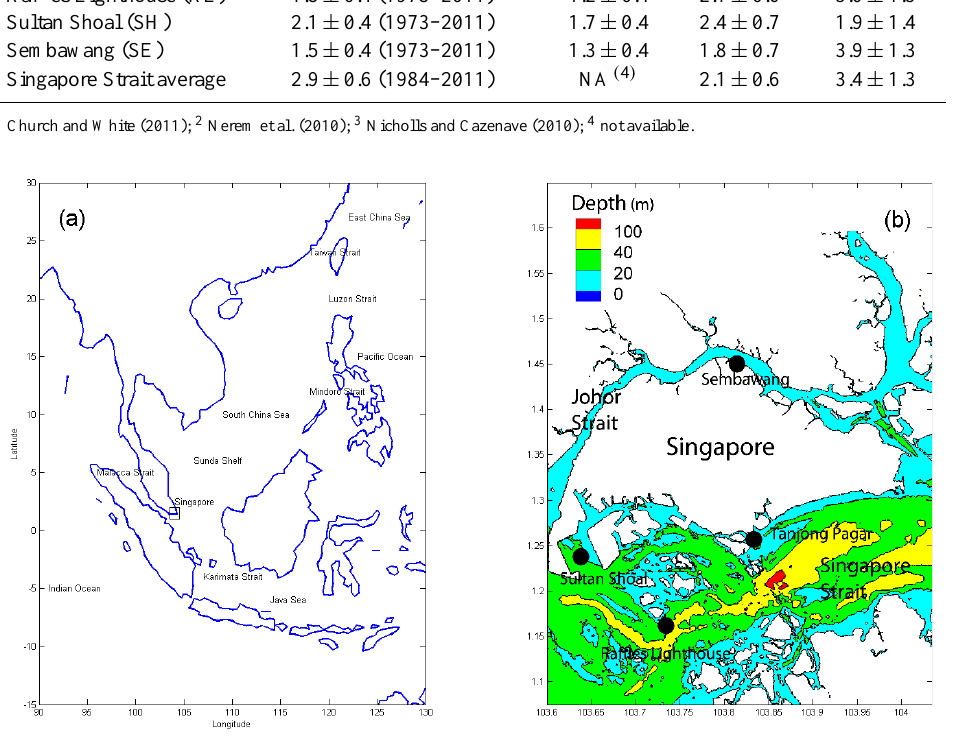
Fig. 1. (a) Study area. (b) The Singapore Strait and its vicinity (bathymetric contours are at 20, 40 and 100m depths). Black symbols denote the locations of 4 tide gauges, namely Tanjong Pagar, Raffles Lighthouse, Sultan Shoal and